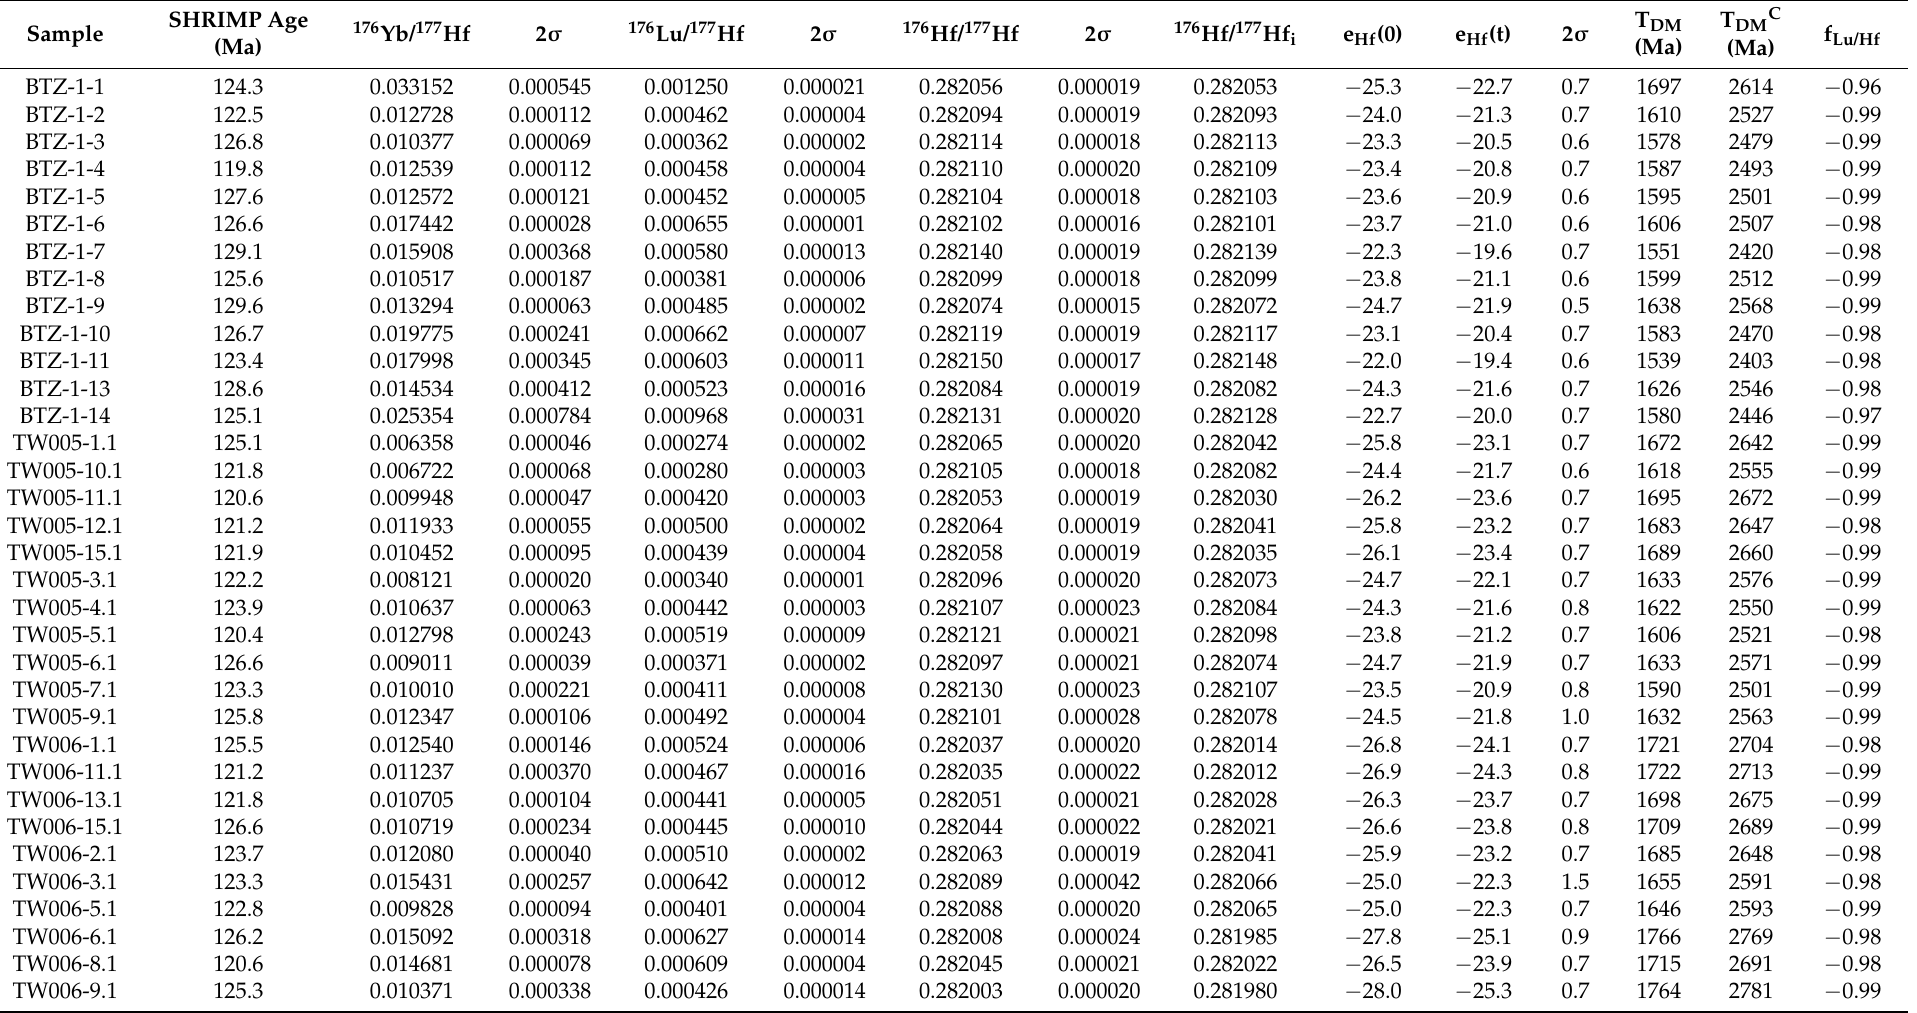
Table 3. Zircon in situ Lu–Hf isotopic data for the host Sanguliu granodiorite and monzodiorite